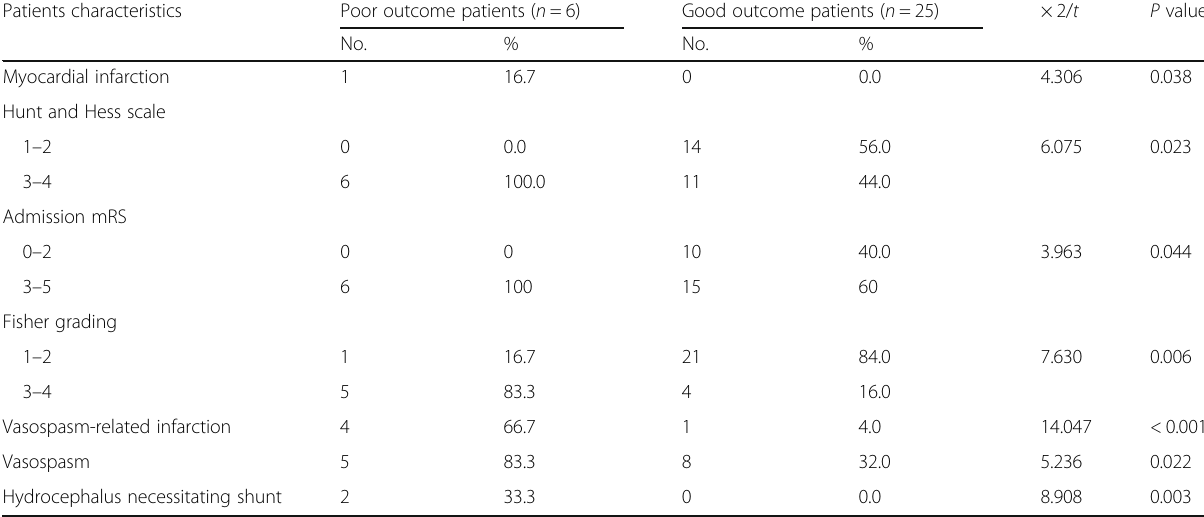
Table 5 Comparison between patients with poor outcome and patients with good outcome according to variables that showed significant differences Patients